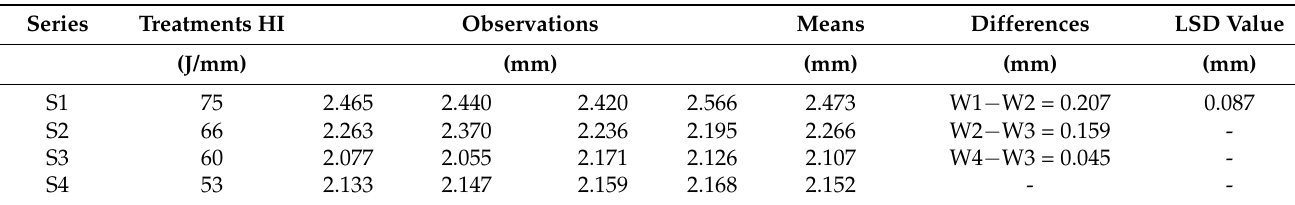
Table 9. Data for width W.